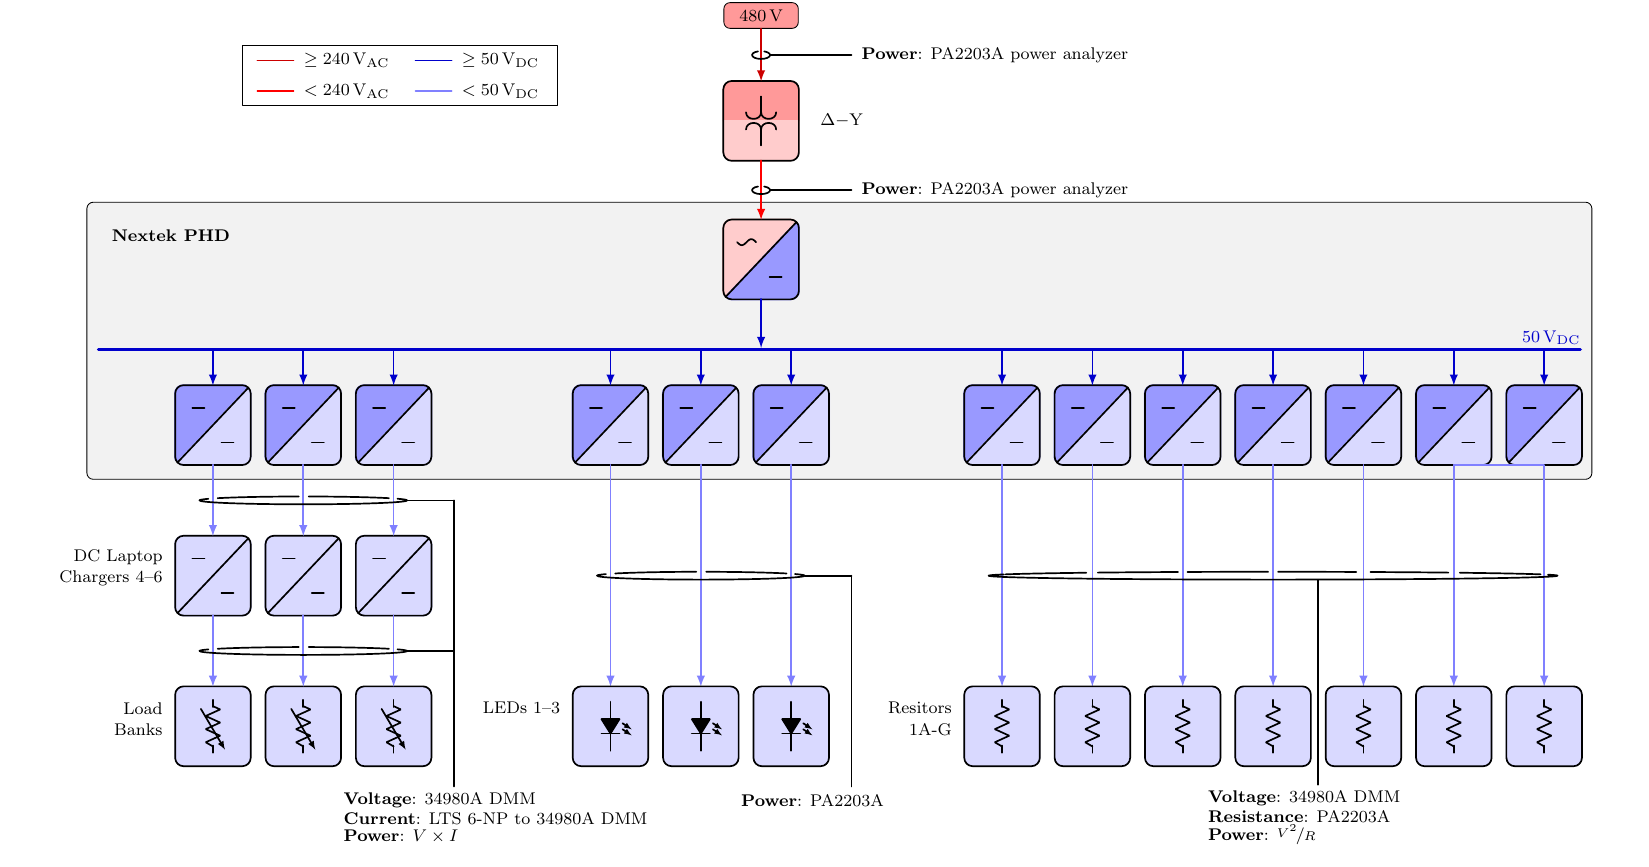
Figure A7. Electrical diagrams for Scenarios 5.4 and